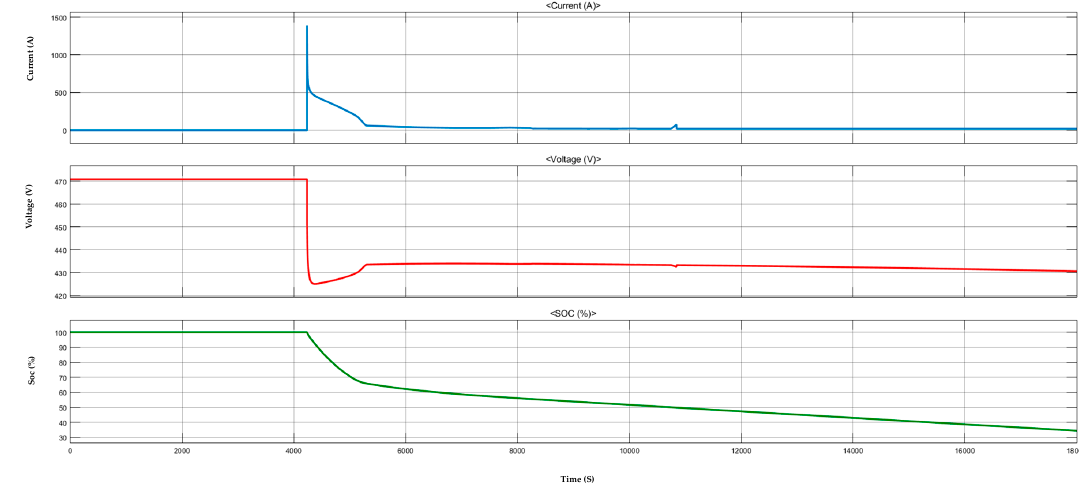
Figure 15. Characteristic curves for system battery.